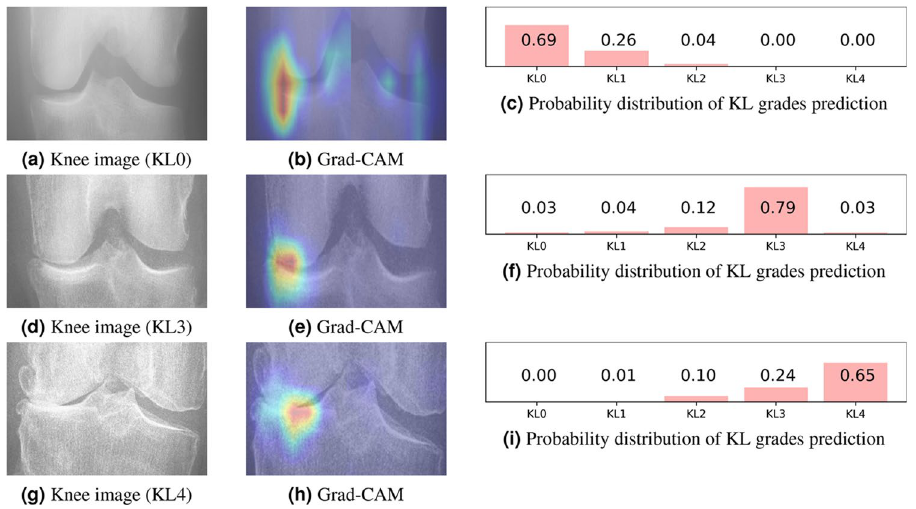
Figure 4. Examples of applying the Grad-CAM algorithm to our proposed model and probability distribution for KL grades